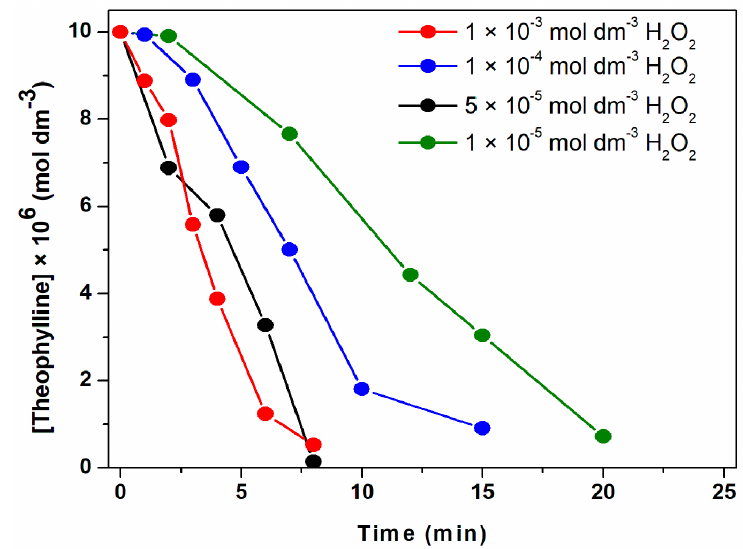
Figure 1. Photo-degradation profile of theophylline (1 × 10 − 5 mol dm − 3 ) in the presence of (red) 1 × 10 − 3 mol dm − 3 , (blue) 1 × 10 − 4 mol dm − 3 , (black) 5 × 10 − 5 mol dm − 3 and (green) 1 × 10 − 5 mol dm − 3 H 2 O 2 .